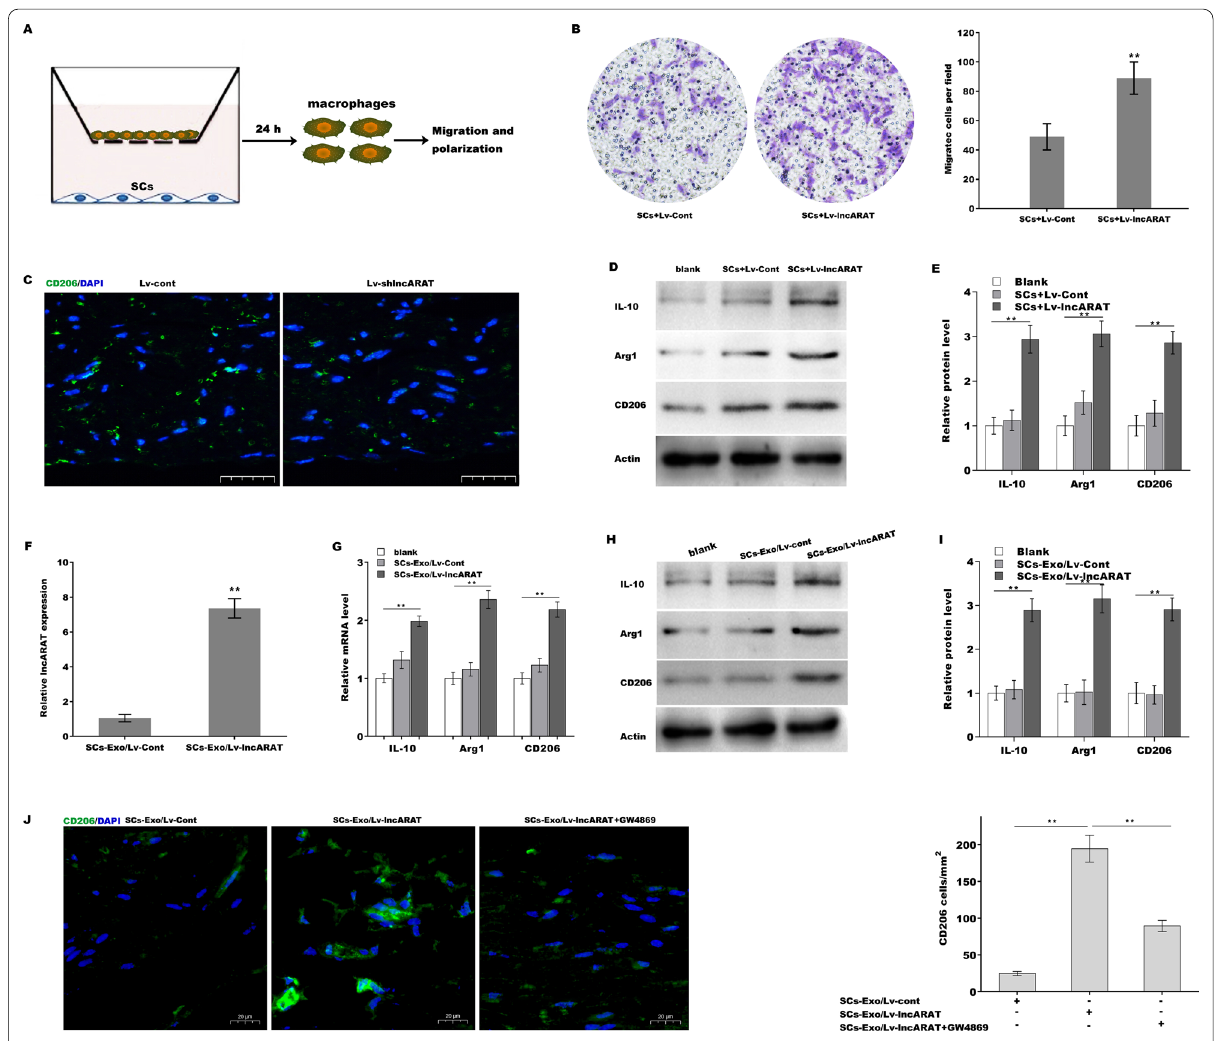
Fig. 3 SCs-Exo activates macrophages into a proregenerative phenotype. A Schematic representation of an in vitro coculture system for assessing the role of SCs in regulating macrophage function. B Transwell migration assay of U937 cells cocultured with SCs for 48 h in the presence or absence of lncARAT overexpression. C IF analysis of CD206 in injured nerves 4 dpi after lncARAT knockdown. Scale bar, 50 µm. D and E Western blot and quantitative analysis of IL-10, CD206, and Arg1 expression in macrophages cocultured with SCs for 48 h in the presence or absence of lncARAT overexpression. F qRT-PCR analysis of lncARAT expression in SCs-Exo/cont and SCs-Exo/Lv-lncARAT. G qRT-PCR analysis of IL-10, CD206, and Arg1 expression in macrophages after treatment with SCs-Exo/Lv-cont or SCs-Exo/Lv-lncARAT for 48 h. H and I Western blot and quantitative analysis of IL-10, CD206, and Arg1 expression in macrophages after treatment with SCs-Exo/Lv-cont or SCs-Exo/Lv-lncARAT for 48 h. J IF and quantitative analysis of CD206 expression in macrophages after treatment with SCs-Exo/Lv-lncARAT in the presence or absence of GW4869 (exosome inhibitor, 10 µM). Scale bar, 50 µm. * p < 0.05. ** p <